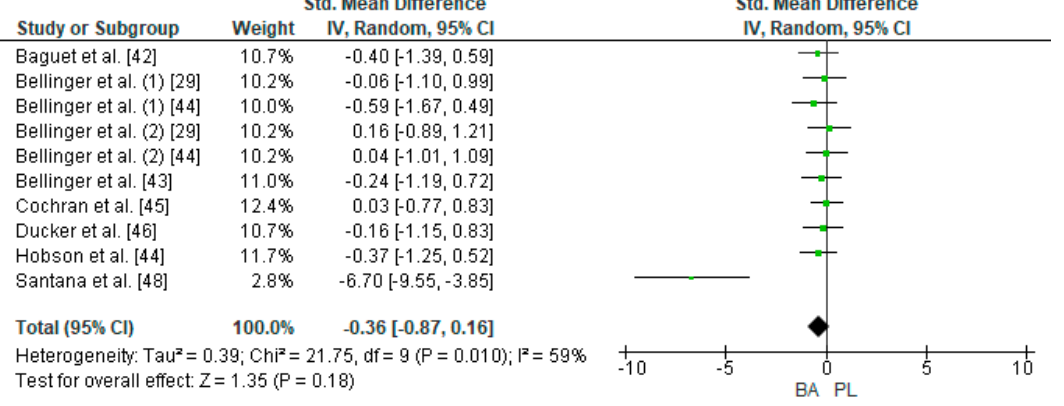
Figure 5. Forest plot comparing the effects of BA supplementation on Time Trial Tests. BA: beta ‐ alanine; PL: placebo.